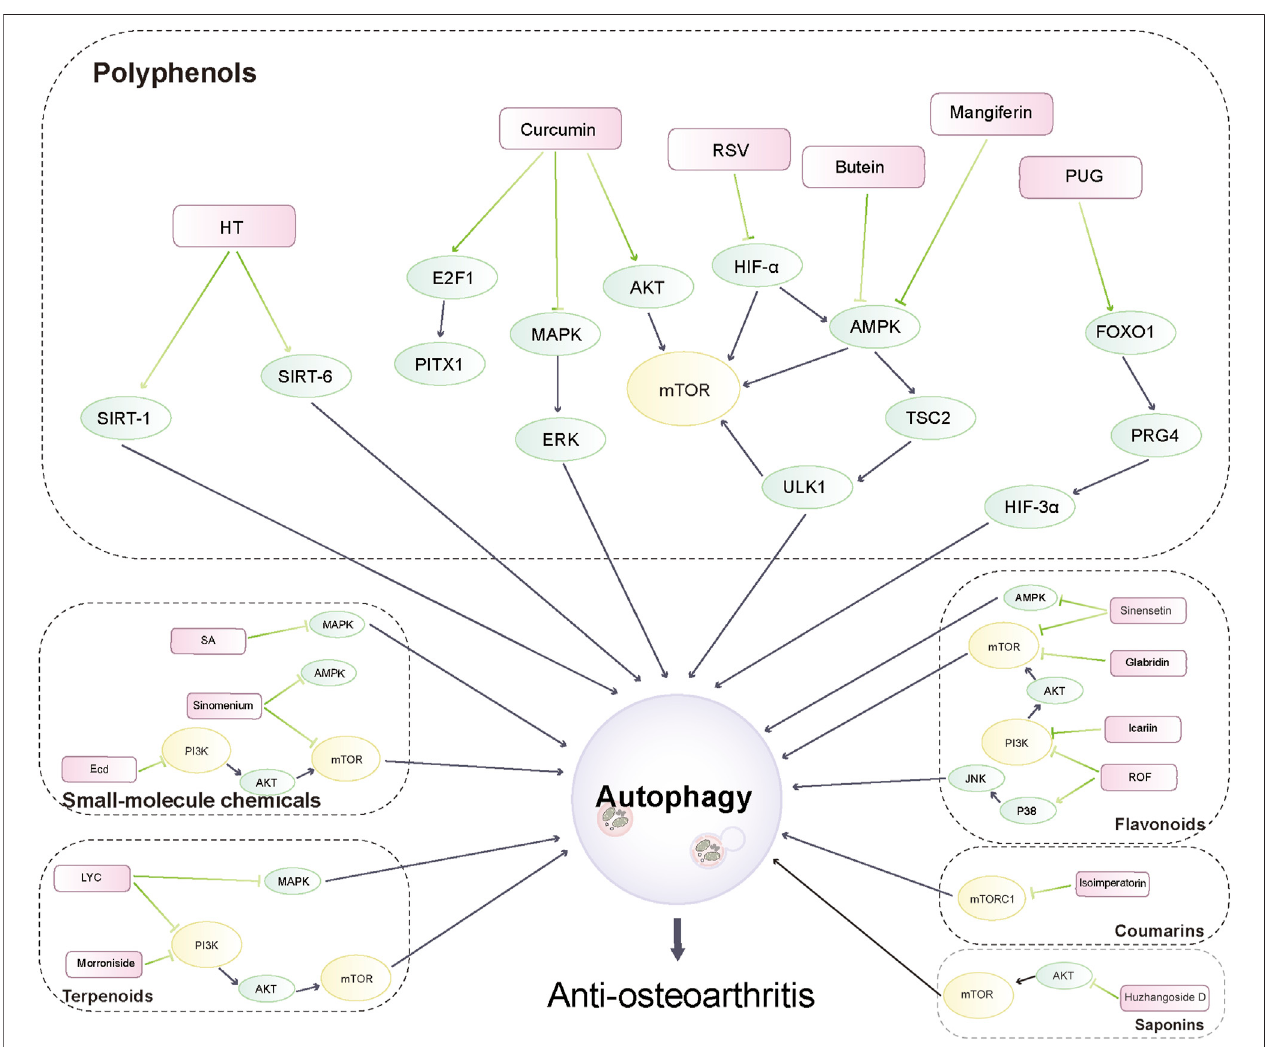
FIGURE 2 | Autophagy pathways of phytochemicals in anti-osteoarthritis.